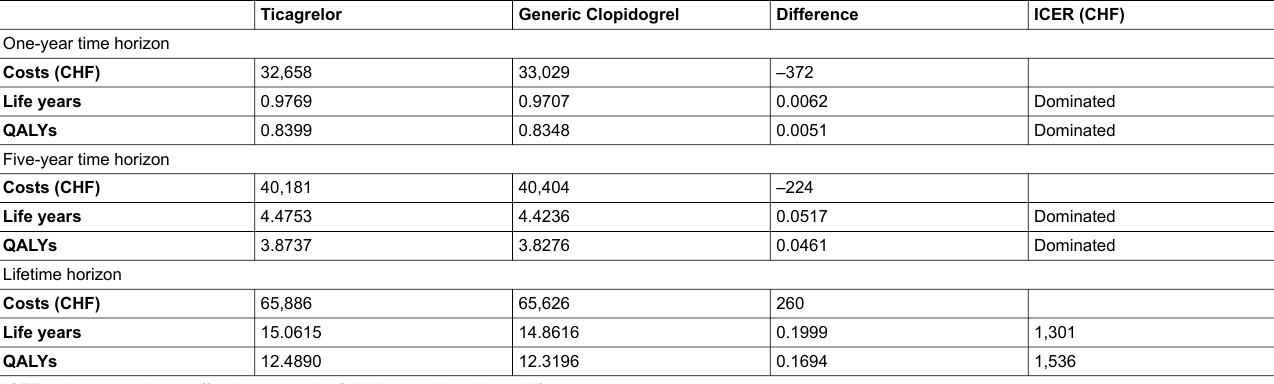
Table 7: Cost-effectiveness of ticagrelor vs. generic clopidogrel for the five-year time and lifetime horizon. Ticagrelor Generic Clopidogrel Difference